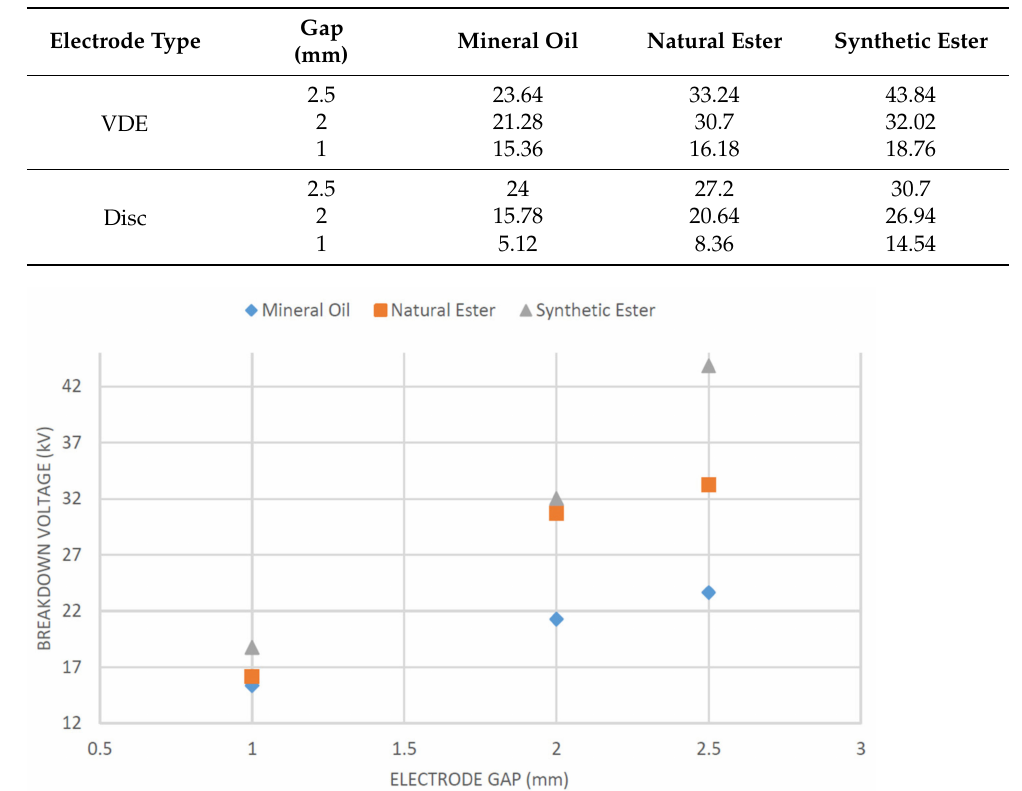
Table 2. AC BDV values.